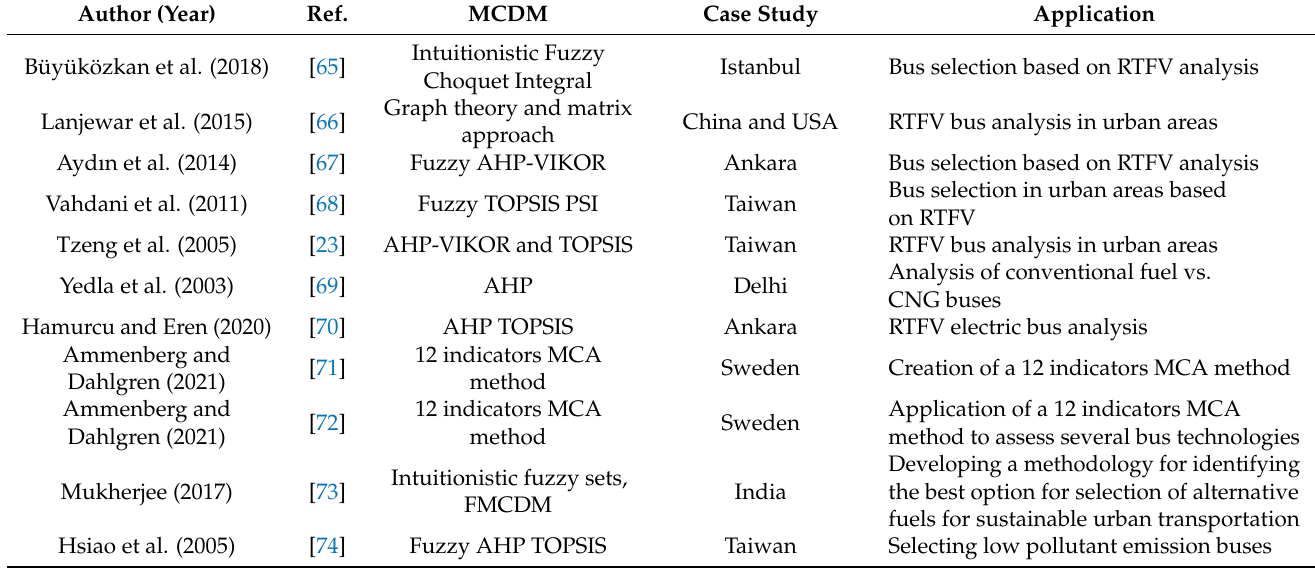
Table 3. Literature review on bus selection based on multi-criteria decision models.